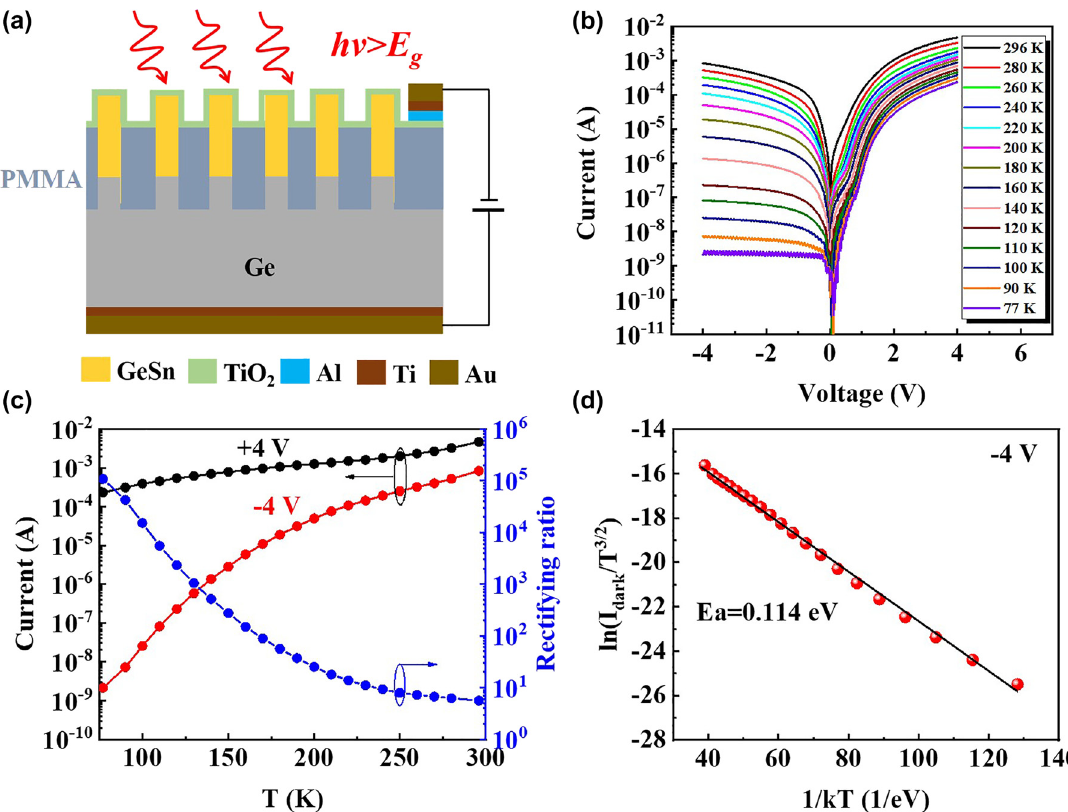
Figure 4: Electrical properties of fabricated GeSn NW PD. (a) Cross-section diagram of the prototype GeSn NW PD. (b) Temperature-dependent I – V curves of the NW PD under dark at 77–296 K. (c) Dark current under + 4 V (black curve), − 4 V (red curve) and current rectifying ratio under ± 4 V (blue / T 3/2 ) on 1/ kT and corresponding linear fitting curve) of the NW PD as a function of temperature. (d) Dependence of ln( I dark